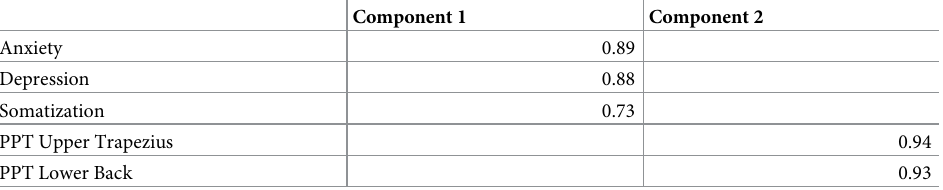
Table 2. Principal components